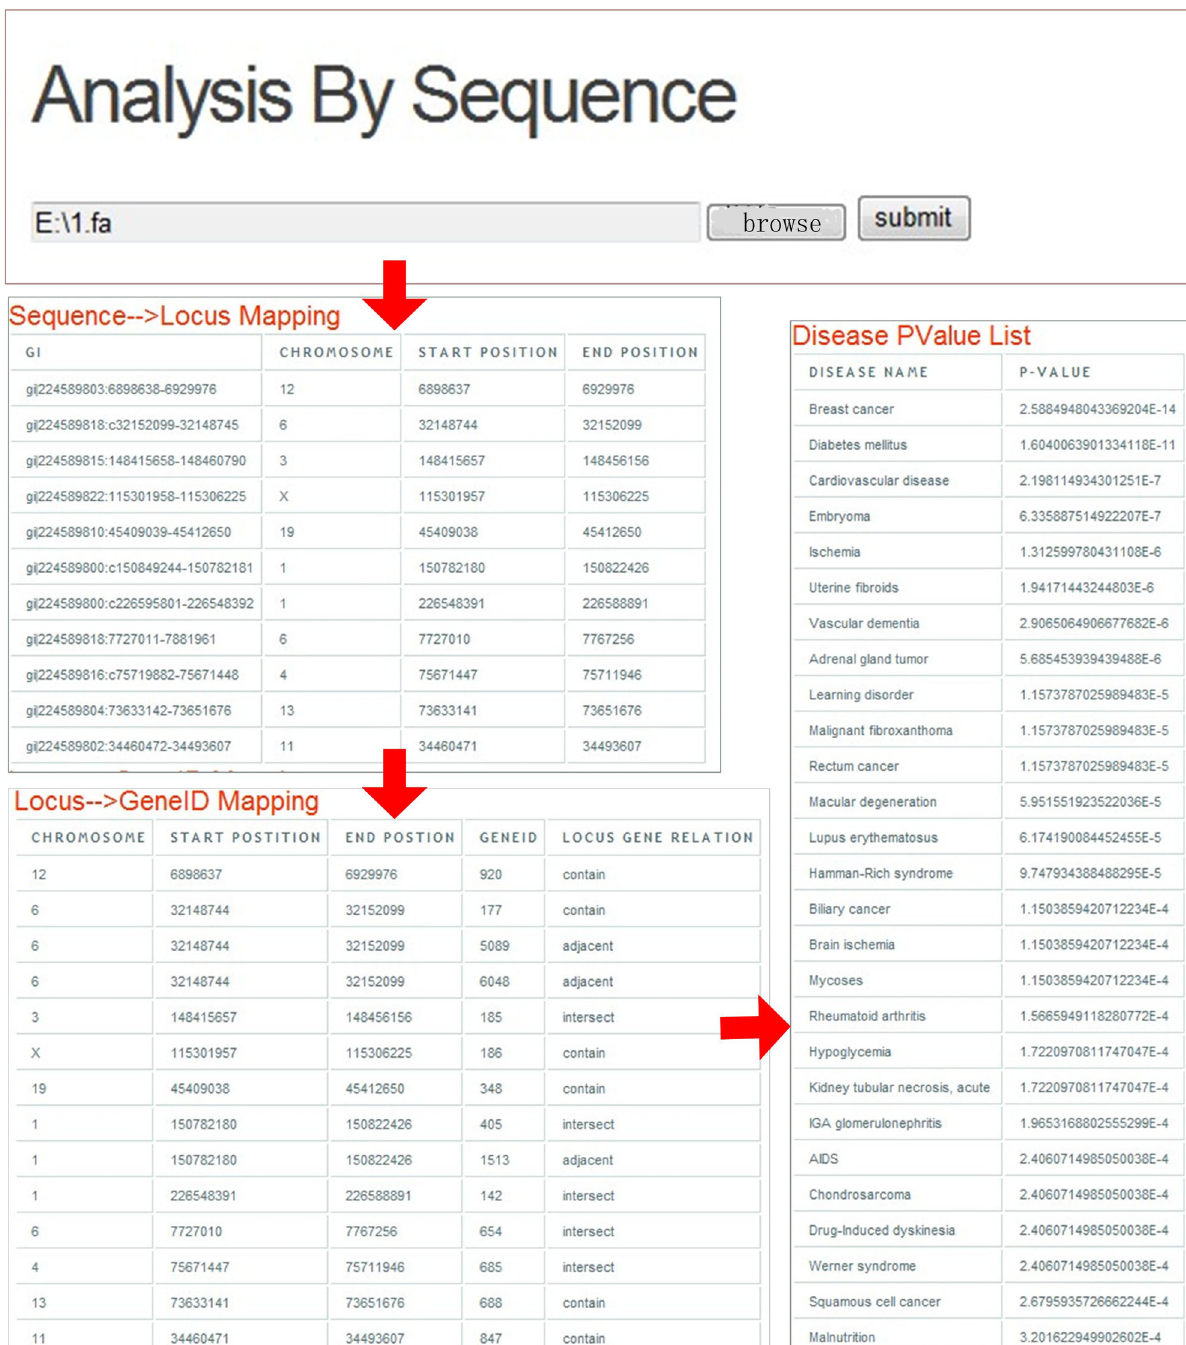
Fig 4. Schematic workflow of identifying significant relationships between sequences and diseases.